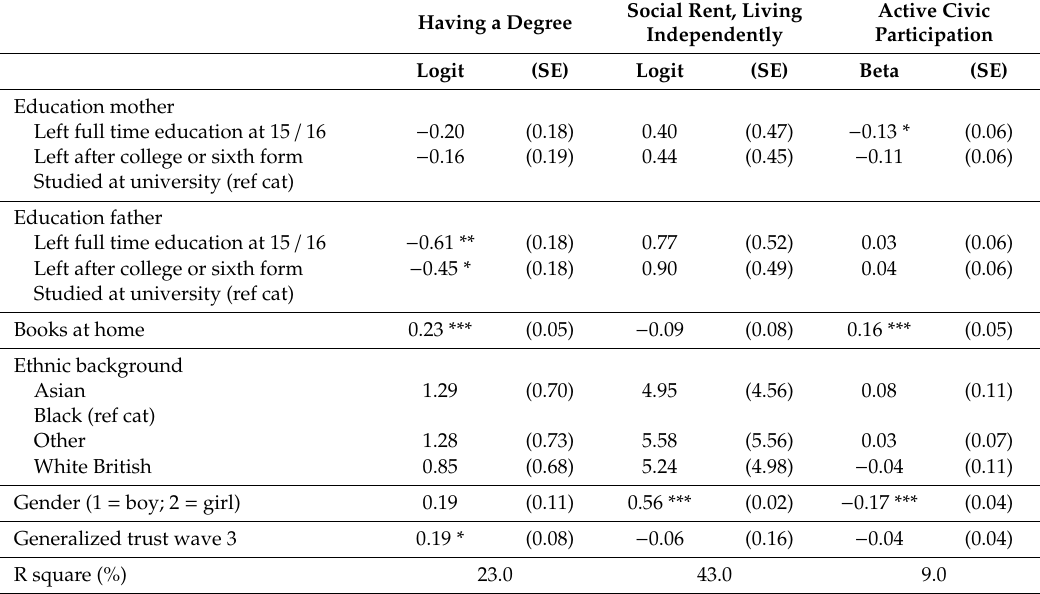
Table 7. Determinants of educational attainment, tenure and active civic